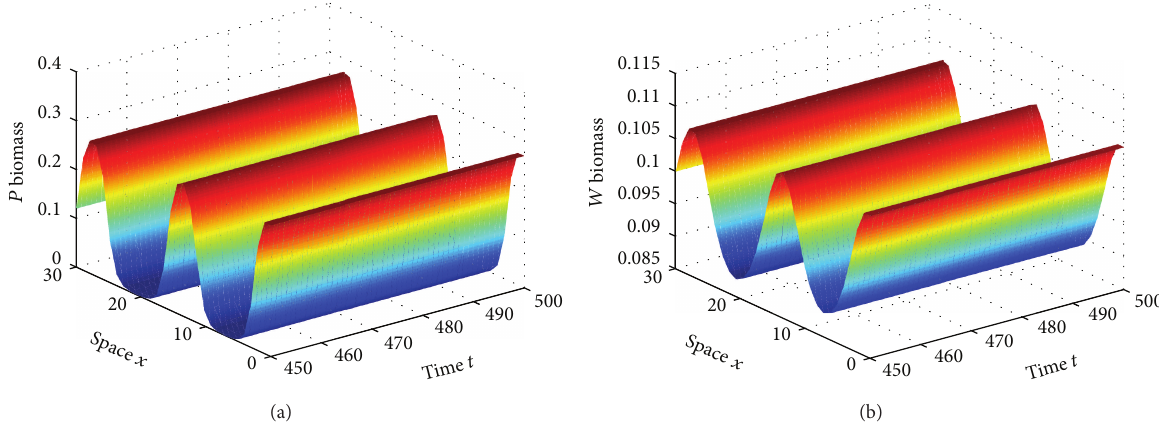
Figure 4: Illustration of the existence of nonconstant positive steady-state solutions of system (2) for 𝑠 = 0 . 25, 𝑏 = 0 . 1, 𝑎 = 10, 𝑘 = 0 . 2, = 0 . 06, and 𝑑 = 10 and initial conditions (𝑃 𝑑 1 2